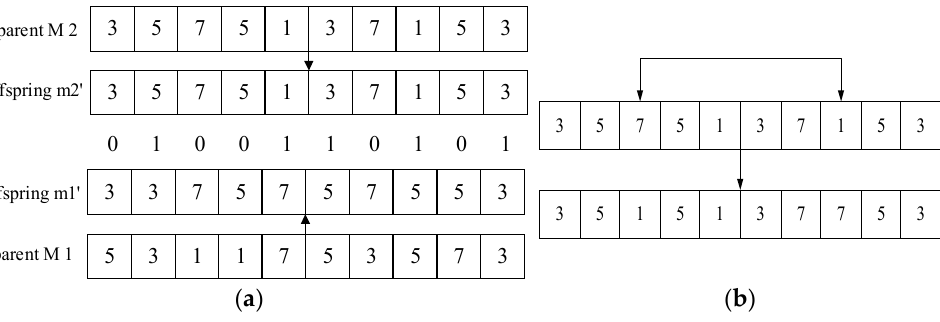
Figure 3. Employed bees search operations. ( a ) Schematic diagram of exchange; ( b ) schematic diagram of mutation.